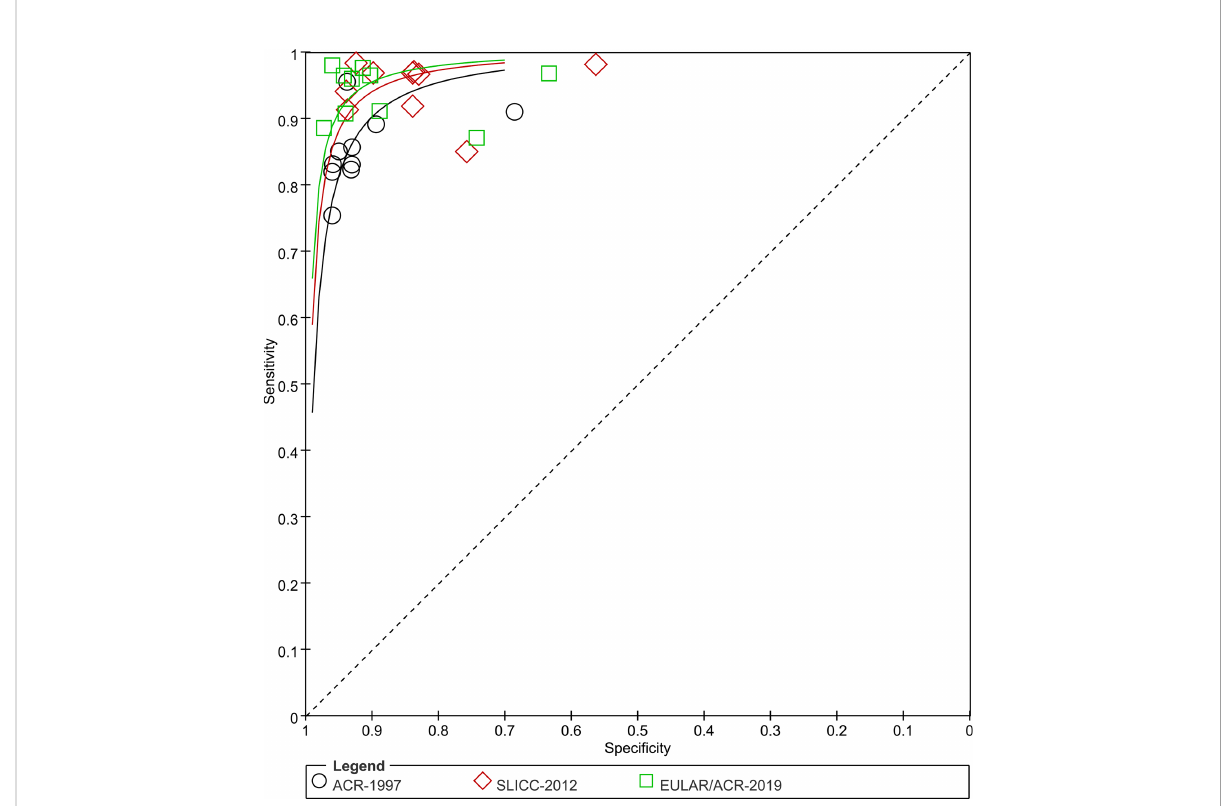
FIGURE 4 SROC plots. Sensitivity and speci fi city of all studies are plotted for ACR-1997, SLICC-2012 and EULAR/ACR-2019 (black circles, red diamonds and green blocks). Studies for SLE are numbered: 1 Adamichou 2020 (9), 2 Aringer 2019 (8) (derivation), 3 Aringer 2019 (6) (validation),